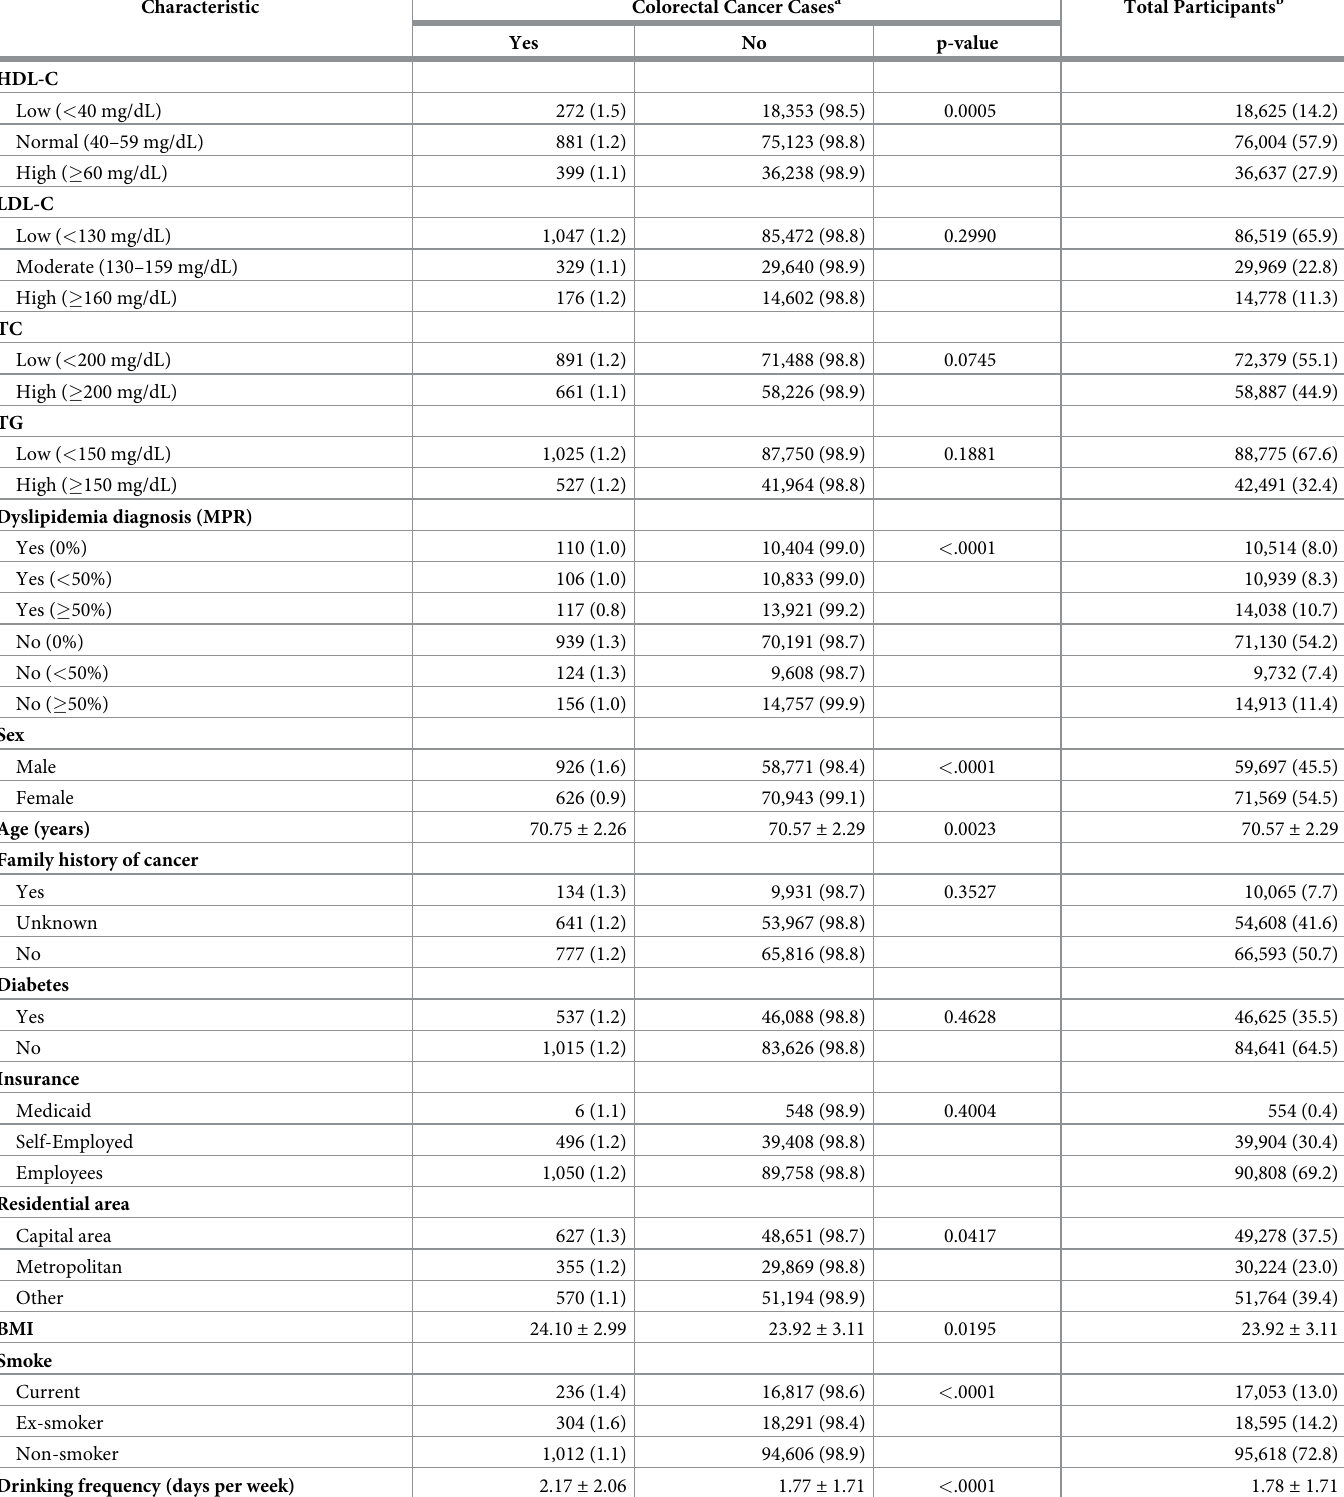
Table 1. Study participants grouped by baseline